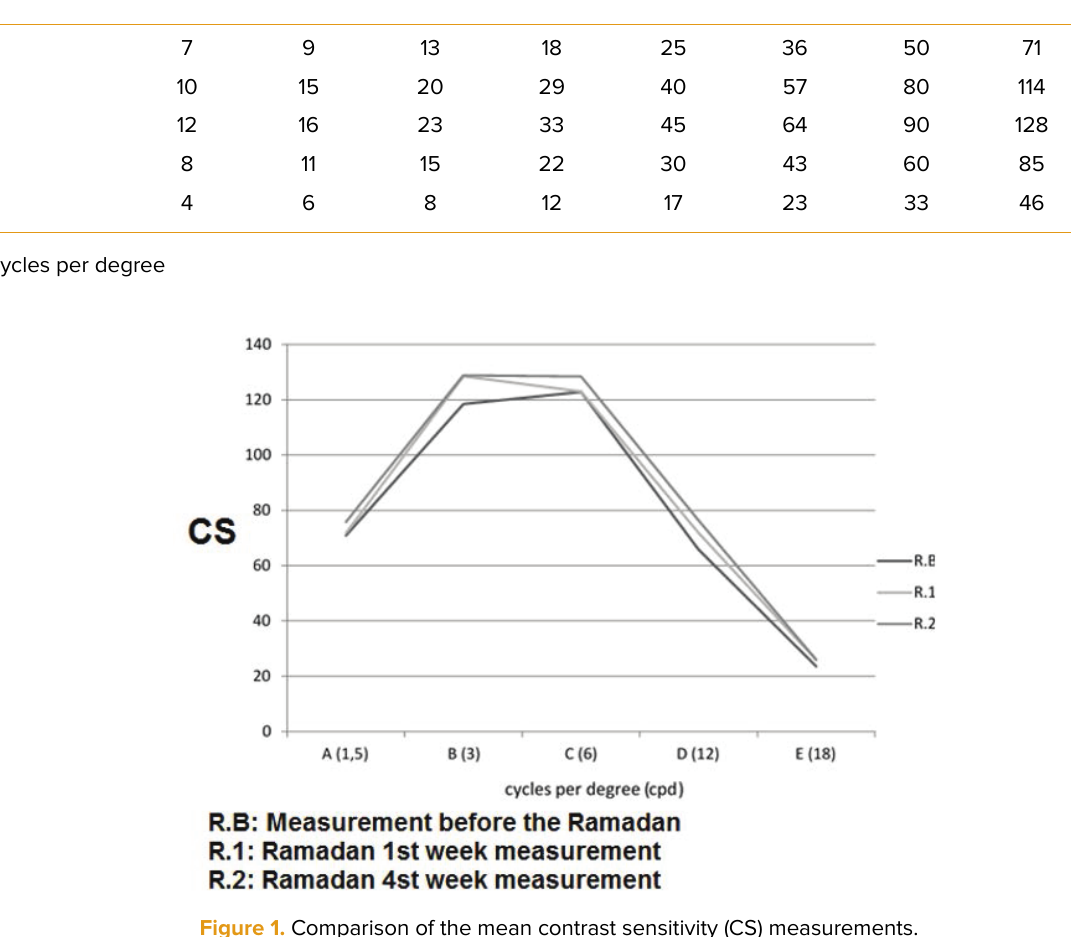
Table 1. The contrast values equivalent to each grating according to spatial frequency Spatial frequency